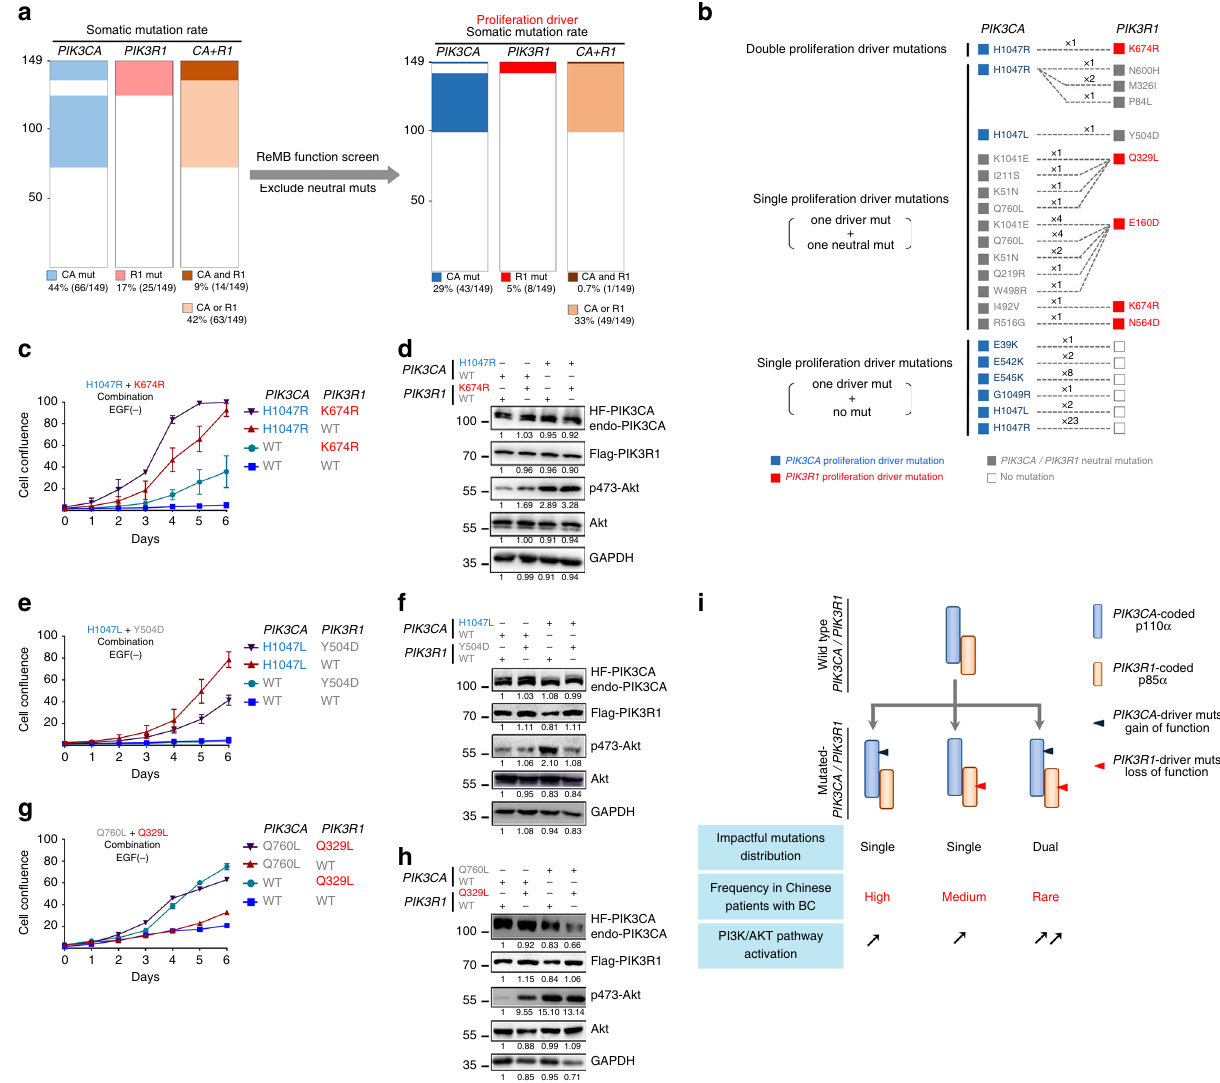
Fig. 6 Combination spectrum of impactful somatic mutations in PIK3CA and PIK3R1 in breast cancer. a A mutually exclusive pattern of proliferation- associated mutations in PIK3CA and PIK3R1 was illustrated in breast cancer by functional screening. Left, somatic mutation frequencies and combined spectrum of PIK3CA and PIK3R1 mutations in the FUSCC cohort; right, proliferation-driver mutation frequencies and the combined spectrum of proliferation-driver mutations after screening. b Prevalence of proliferation-driver mutations in individual cancers: PIK3CA -driver mut (blue); PIK3R1 -driver mut (red); PIK3CA or PIK3R1 non - driver mut (gray); no mutation (empty). c , e , g Growth properties of MCF-10A cells expressing a variety of combined PIK3CA and PIK3R1 mutations. Five wells were measured per condition. The error bars indicate ± s.d. derived from three independent experiments. d , f , h The levels of p-AKT at Ser-473 in the indicated cells were analyzed by western blotting. Western blots were representative of three independent experiments. i Hypothetical schematic model of dual impactful mutations of PIK3CA and PIK3R1 that regulate the PI3K